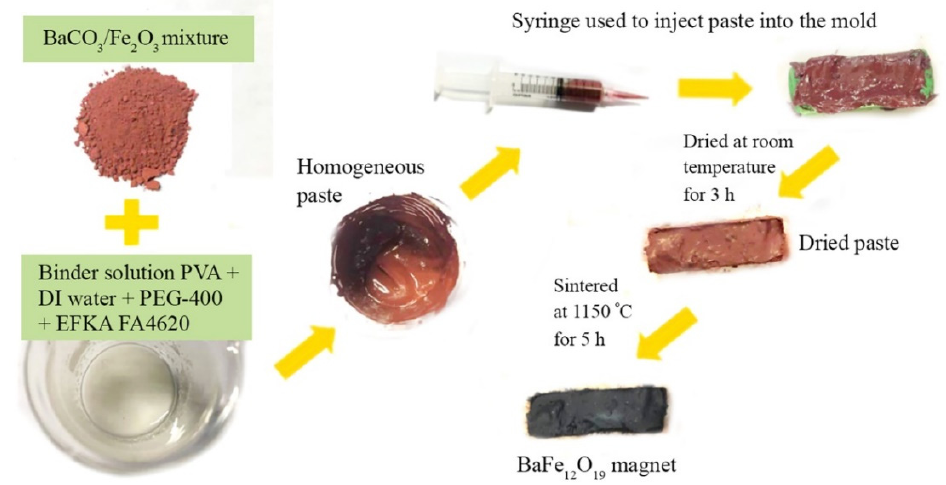
Figure 2. Production steps for BaFe 12 O 19 magnets from paste-injection molding (2CP5).